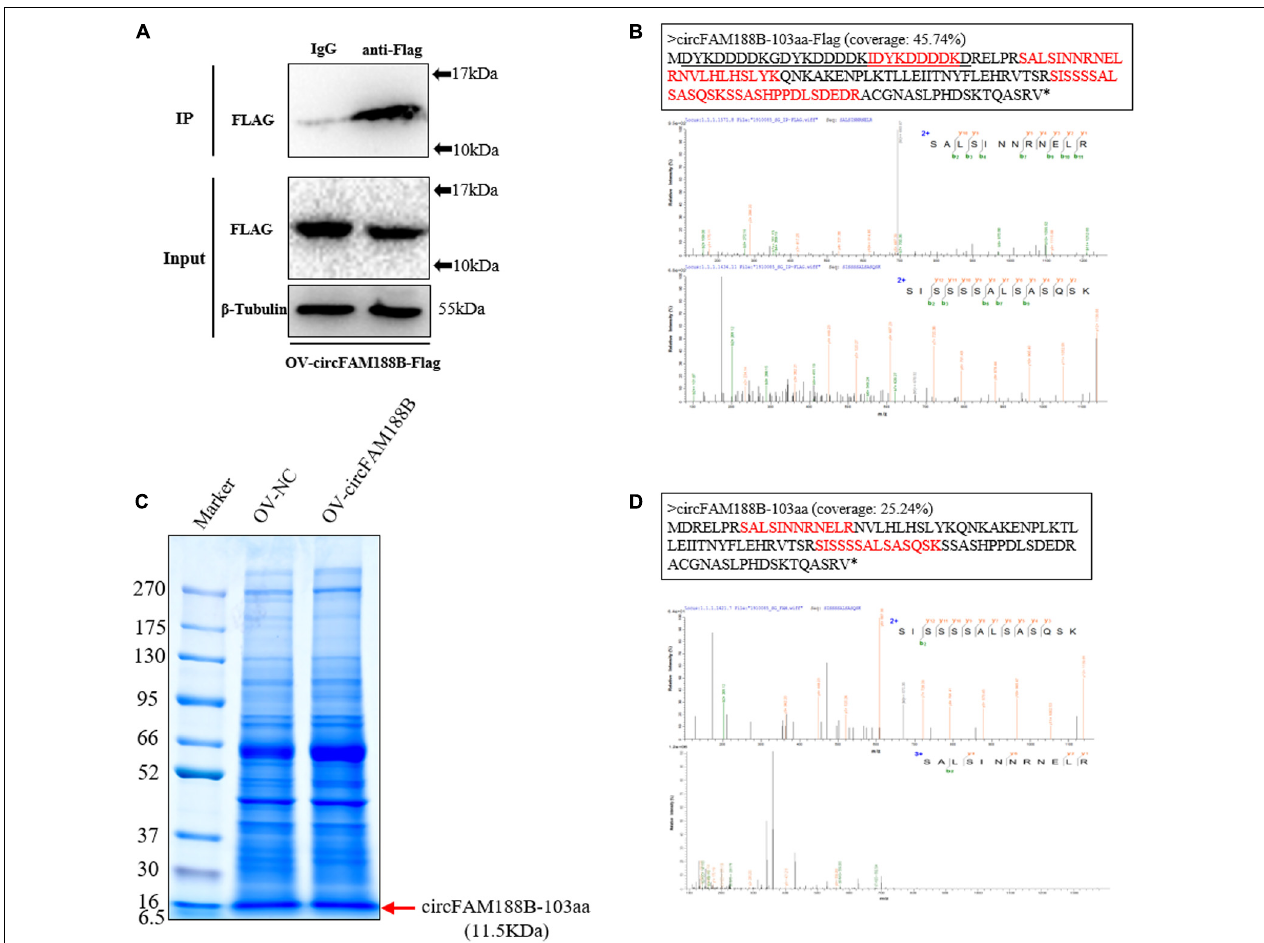
FIGURE 6 | Identification of the novel protein circFAM188B-103aa. (A) The Flag-tagged protein of the sample used in IP assays was detected by western blot analysis. (B) LC-MS/MS-identified amino acid sequences of the Flag-tagged circFAM188B-103aa (red, upper panels ), the specific charge of corresponding peptide (lower panels) . (C) Total cell lysates were separated by SDS-PAGE. Bands representing proteins between 10–17 kDa were excised manually and submitted for identification by LC-MS/MS. (D) LC-MS/MS-identified amino acid sequences of the circFAM188B-103aa (red, upper panels ), the specific charge of corresponding peptide (lower panels)